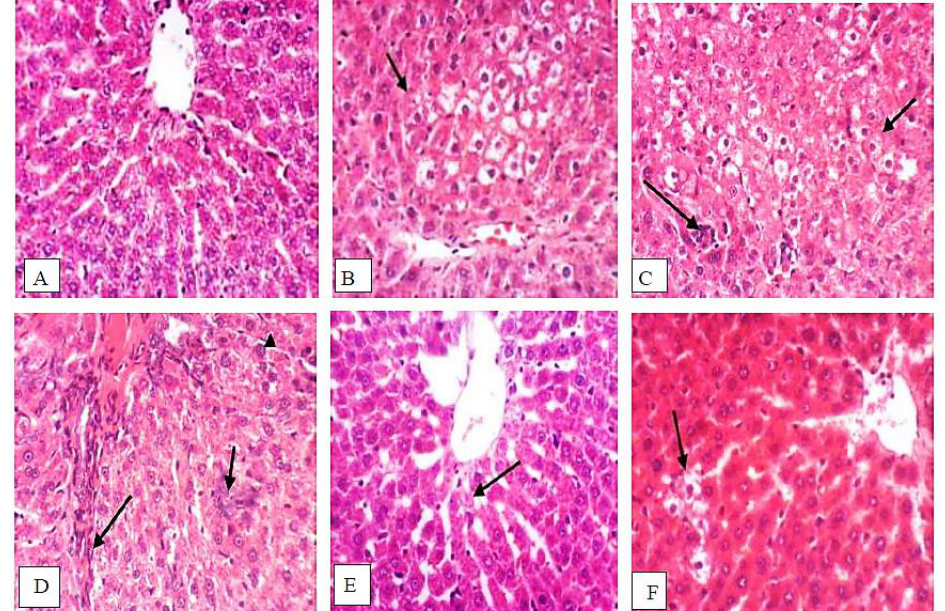
Figure 10. Isatin partially prevented the histopathologic changes induced by DENA/2-AAF. ( A ) Normal histological structure of the hepatic lobule in sections from control group rats. ( B – D ) Severe histopathological changes in liver sections from DENA/2-AAF-treated rats, including large clear hepatocellular foci surrounded by proliferating oval cells, fibroblast proliferation, and karyomegaly of hepatocytic nuclei. Moreover, HCC model liver also contained many cells with centrally located nuclei and several large hepatocellular foci with pale cytoplasm. ( E , F ) Isatin cotreatment greatly reduced but did not eliminate these histopathological signs (H&E; 400×).